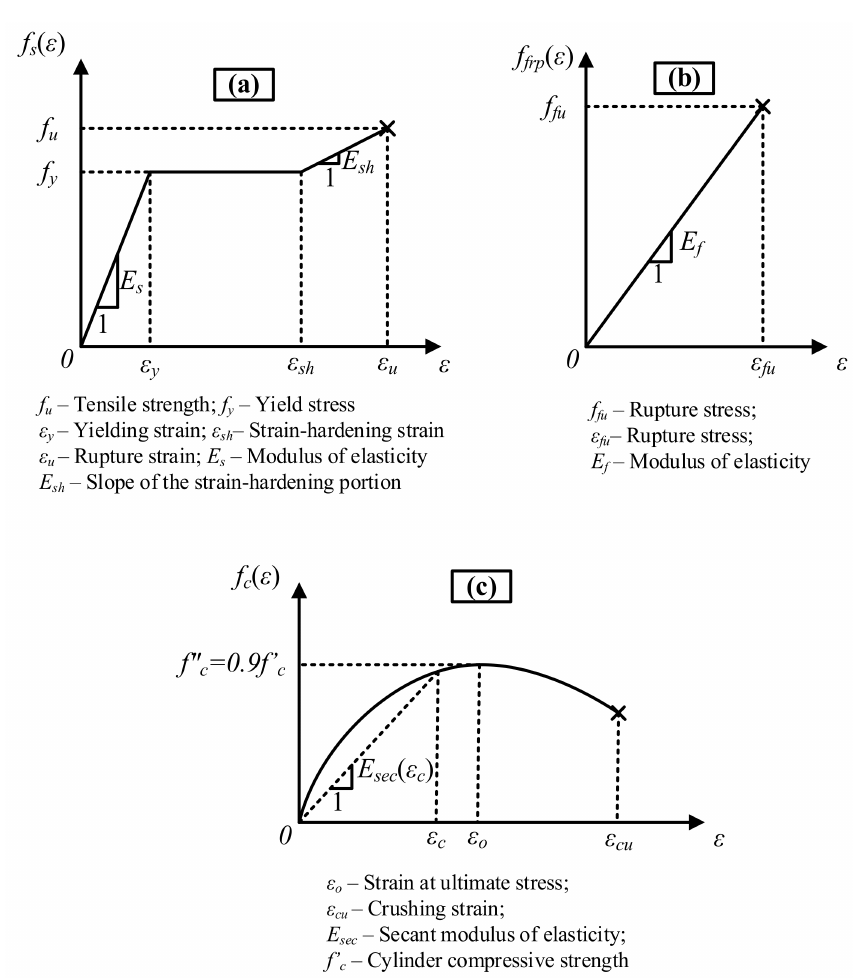
Figure 9. Stress-strain curves for ( a ) steel under tension; ( b ) FRP under tension; and ( c ) concrete under